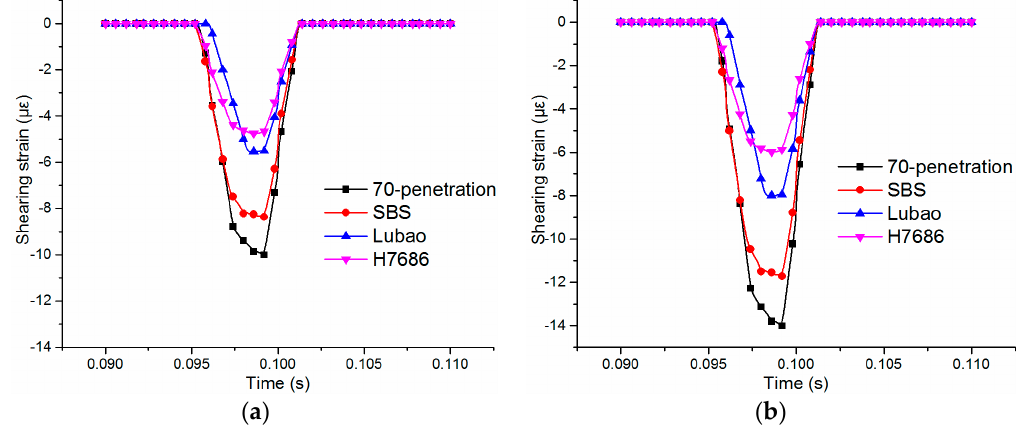
Figure 7. Shearing strains of middle surface layers: ( a ) under standard load; ( b ) under heavy load.